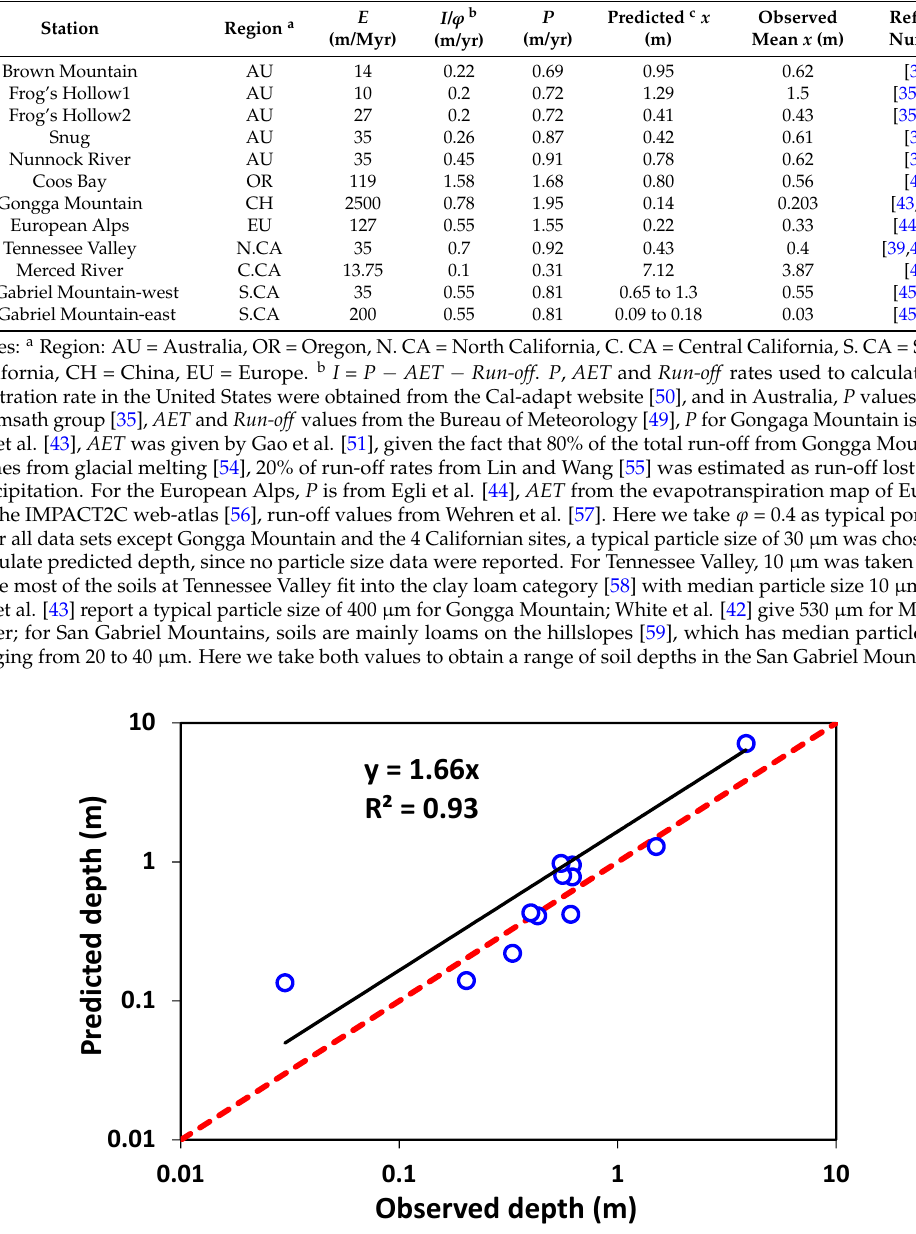
Figure 1. Comparison of the predicted soil depth via Equation (2) versus the observed depths for 12 sites (open circuits) from all around the world. The dashed red line represents the 1:1 line. See Table 1 for further details.